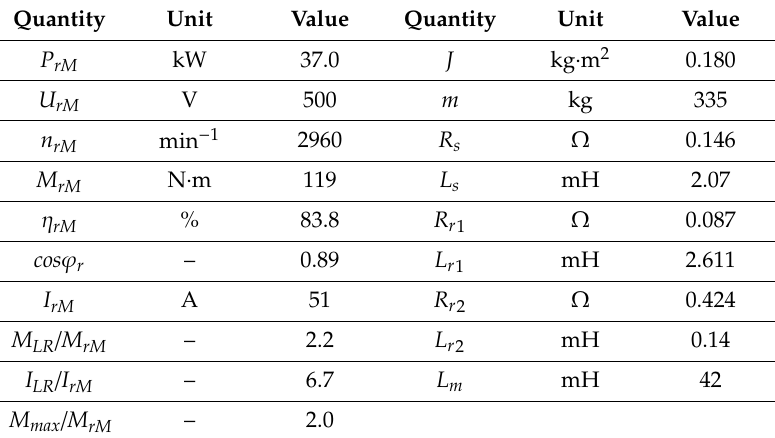
Table 2. Parameters of the dSOKg 200L2B-E motor